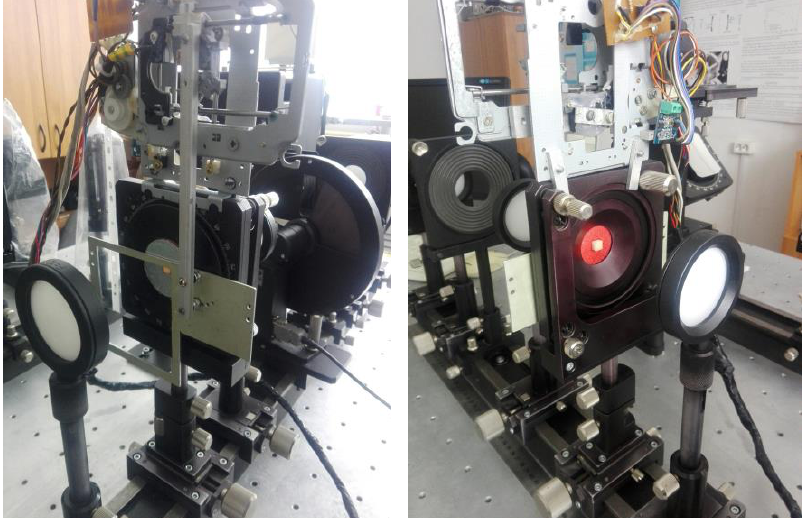
Fig. 2. The location of the focusing element in the terahertz imaging system.